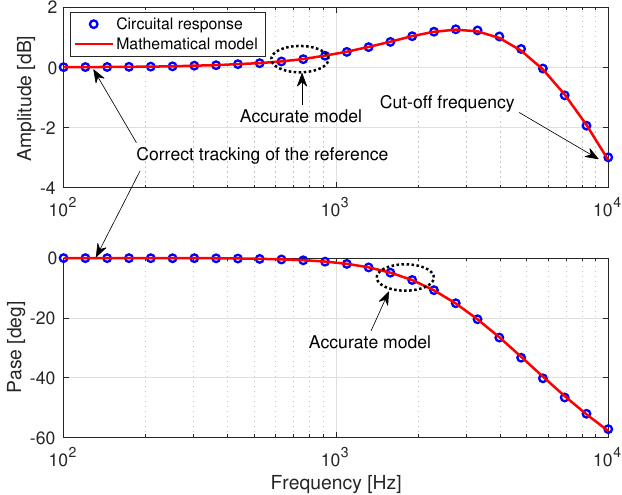
Figure 13. Frequency response of the PV system in closed loop.